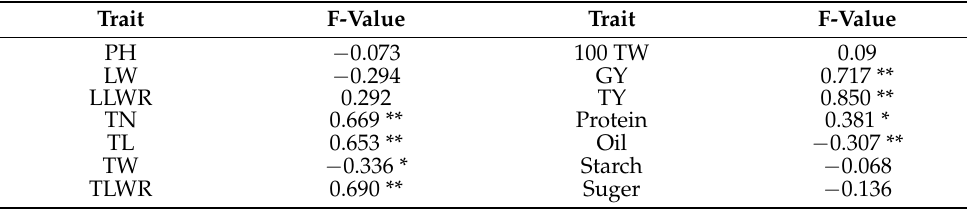
Table 7. Correlation coefficients between 14 phenotypic traits and comprehensive value. Trait